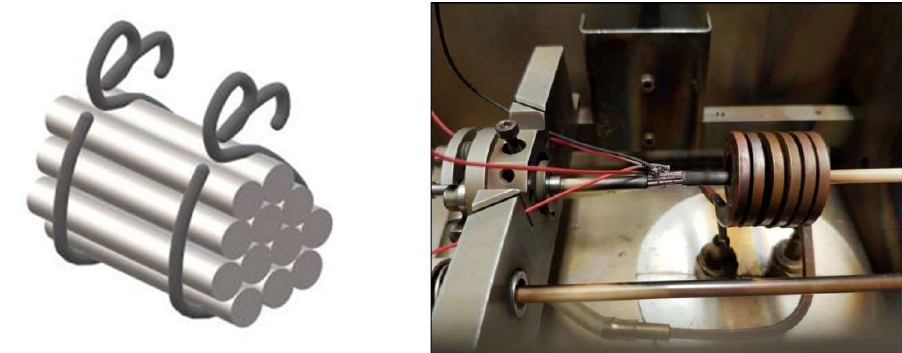
Figure 2. Schematic of specimen wire bundle as used for dilatometry and experimental setup within the quenching dilatometer. One specimen consists of twelve wire sections made of H11 tool steel with an individual diameter of 1 mm and a length of 10 mm. Molybdenum wire with a diameter of 0.3 mm was used to prepare the bundles and minimize thermal and/or chemical influence on the tool steel.